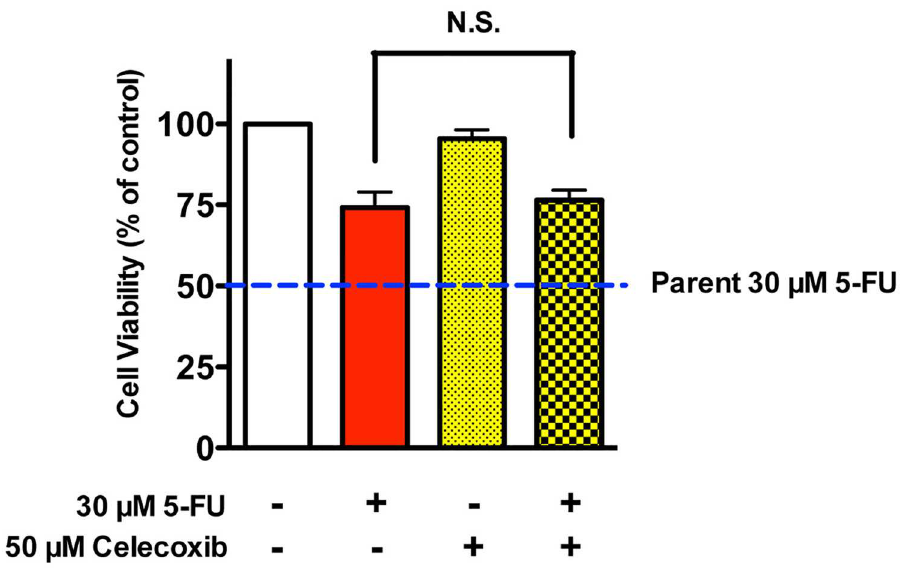
Fig 4. Effect of celecoxib on the cytotoxicity of 5-FU against MDA-MB-231BR. Cytotoxicity of 5-FU to MDA-MB-231BR in the presence of 50 μ M celecoxib. Blue broken lines parallelto x-axis represent the cell viabilityof MDA-MB-231 (Parent) treated with 30 μ M 5-FU. Data represent the mean with SEM of four independent